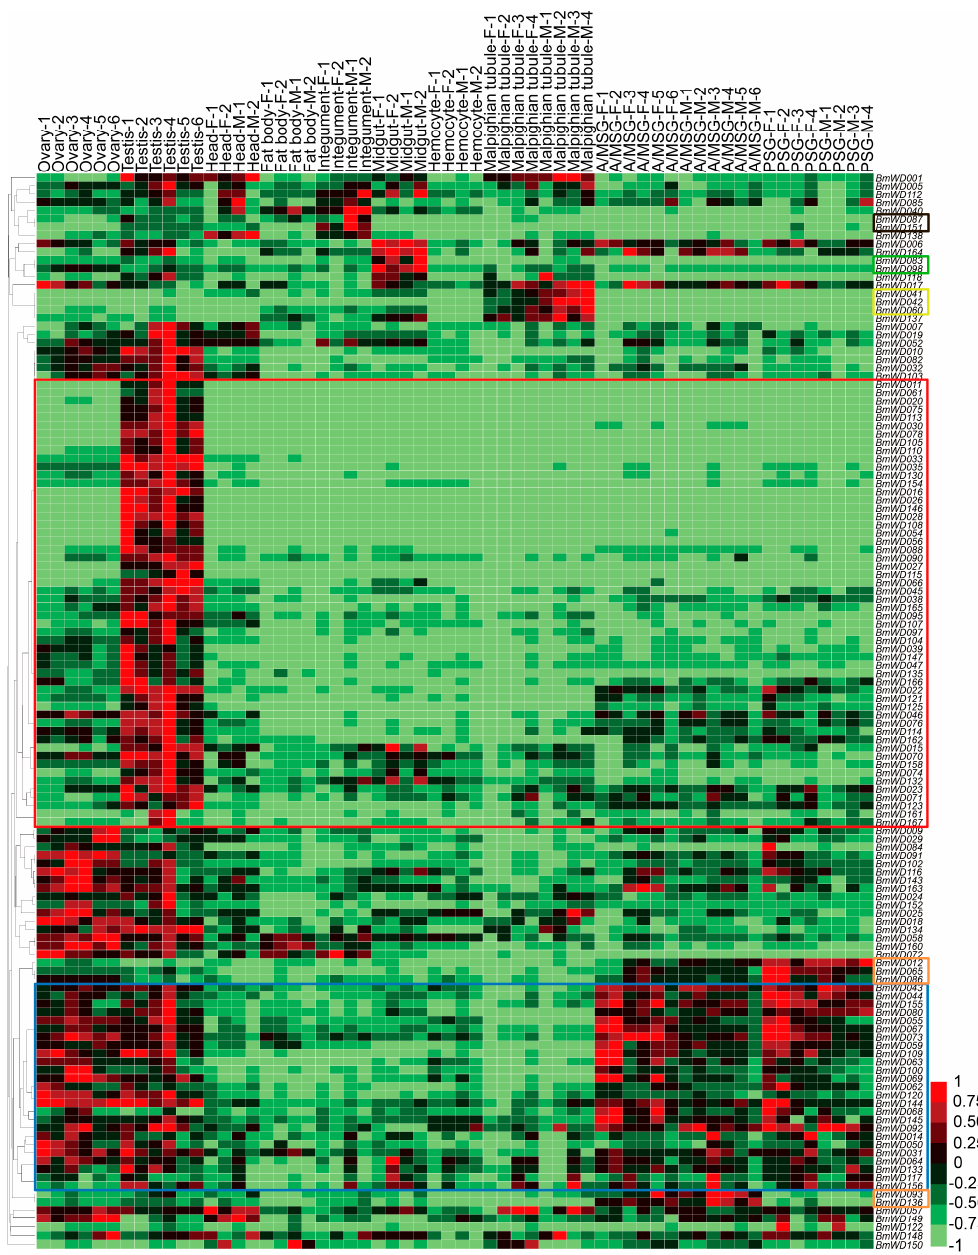
Figure 8. Microarray-based gene expression profiling of BmWD40 genes in multiple tissues of silkworm larvae. The microarray gene expression dataset in multiple larval tissues of the silkworm on Day 3 of the fifth instar was downloaded from the SilkDB database. Repeated samples of each tissue are indicated with different numerals. A/MSG: Anterior/Median Silk Gland, PSG: Posterior Silk Gland, F: Female, M: Male. Red box indicates highly-expressed testis-specific genes. Blue box indicates the genes with high expression in gonad and silk glands. Orange boxes indicate the genes with silk-gland-specific high expression. Yellow box indicates genes that showed Malpighian-tubule-specific high expression. Green box indicates genes that were mainly expressed in the midgut. Black box indicates genes that were highly expressed in the integument.